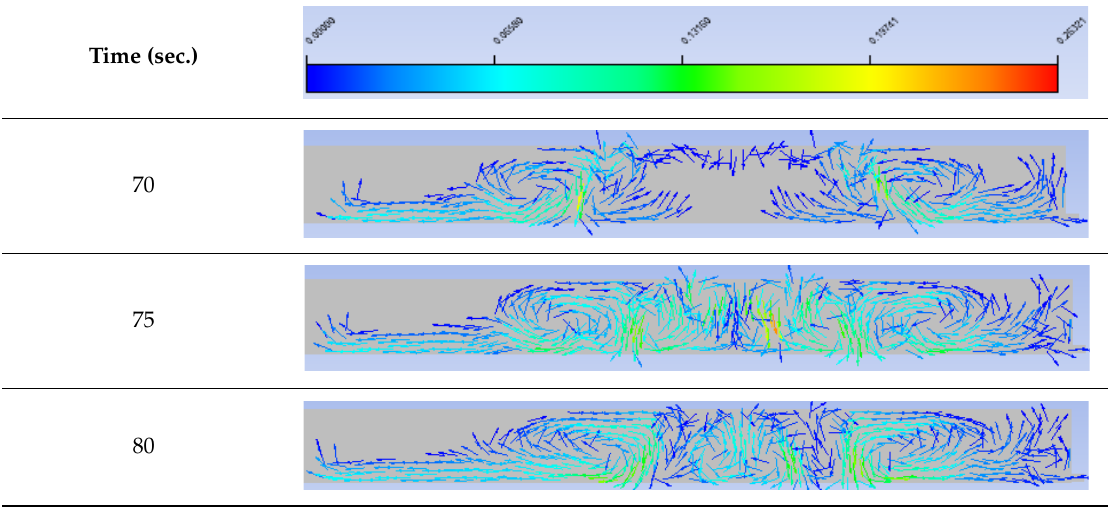
Figure 4. Number fraction distribution of different-sized droplets inside the settler. 3.2. Coupled CFD–DEM Simulation The CFD–DEM simulation revealed a strong funneling effect in the settling droplet cloud. The effect was caused by the drag of the settling matte, pulling droplets towards the centerline of the cloud, and subsequently increasing the bulk density as the droplets became more closely packed. This caused an increased settling velocity which, in turn, increased the drag, and thus, created a self- sustaining funneling effect. However, the CFD–DEM simulation did not show the development of two light matte streams that can be seen at 15 s in Table 4. The development of the effect is shown in Figure 6.